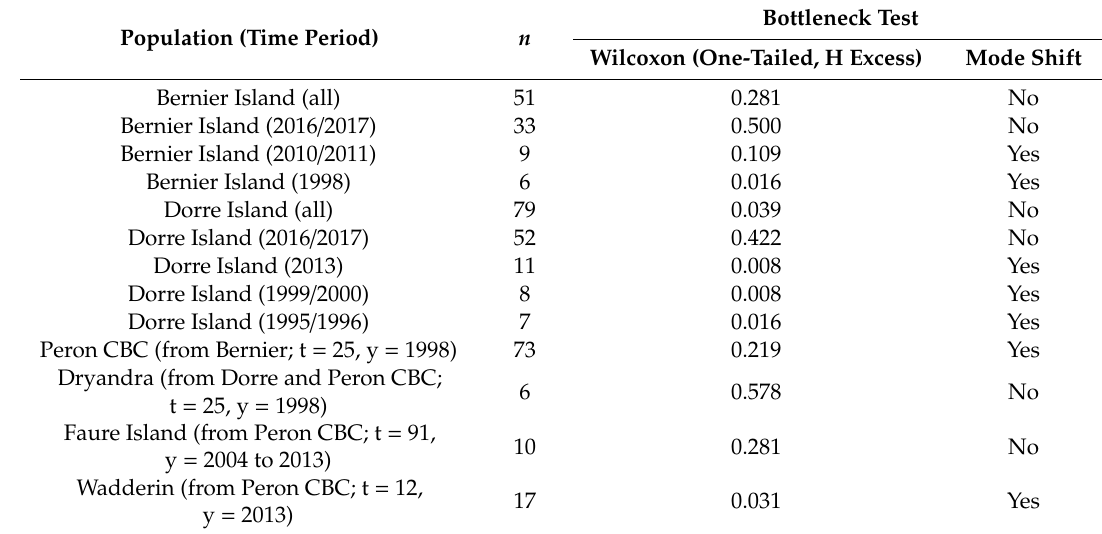
Table 4. Results of two tests for a genetic bottleneck of source and translocated